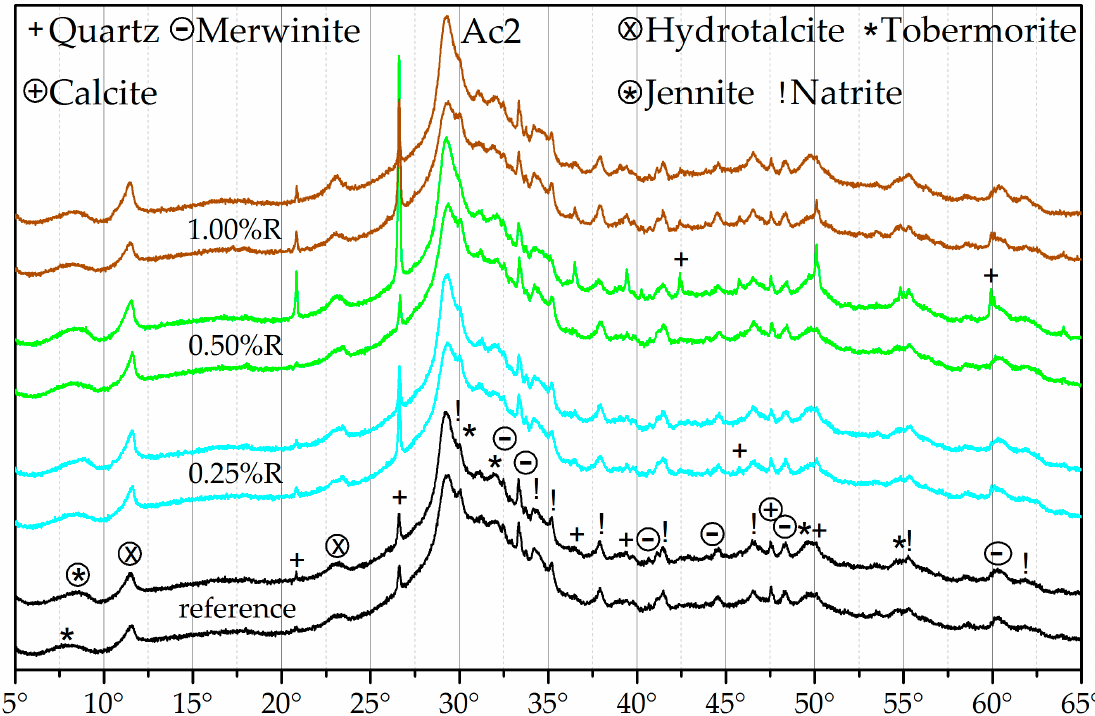
Figure 6. X-Ray diffractogram of the reference of Ac2 (without retarder) and the reactivated mixtures with Ac2 after seven days of retardation of 0.25%, 0.50%, and 1.00%R—after hydration periods of seven (lower curve) and 28 days (upper curve) per test, with an angular range of 2 θ .